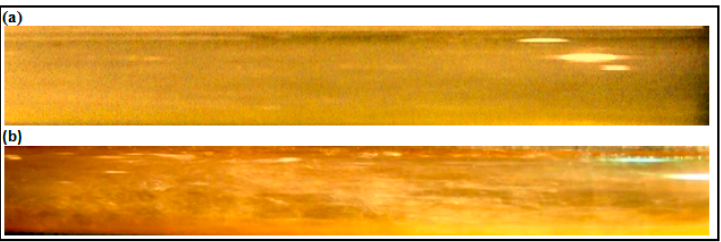
Figure 9. ( a ) Typical feature of a Dispersed Bubbly flow regime (V sl =3.08 m/s, V sg = 1.03 m/s) ( b ) Transition from Dispersed Bubbly to Pseudo slug flow regime with 40 ppm DRP.